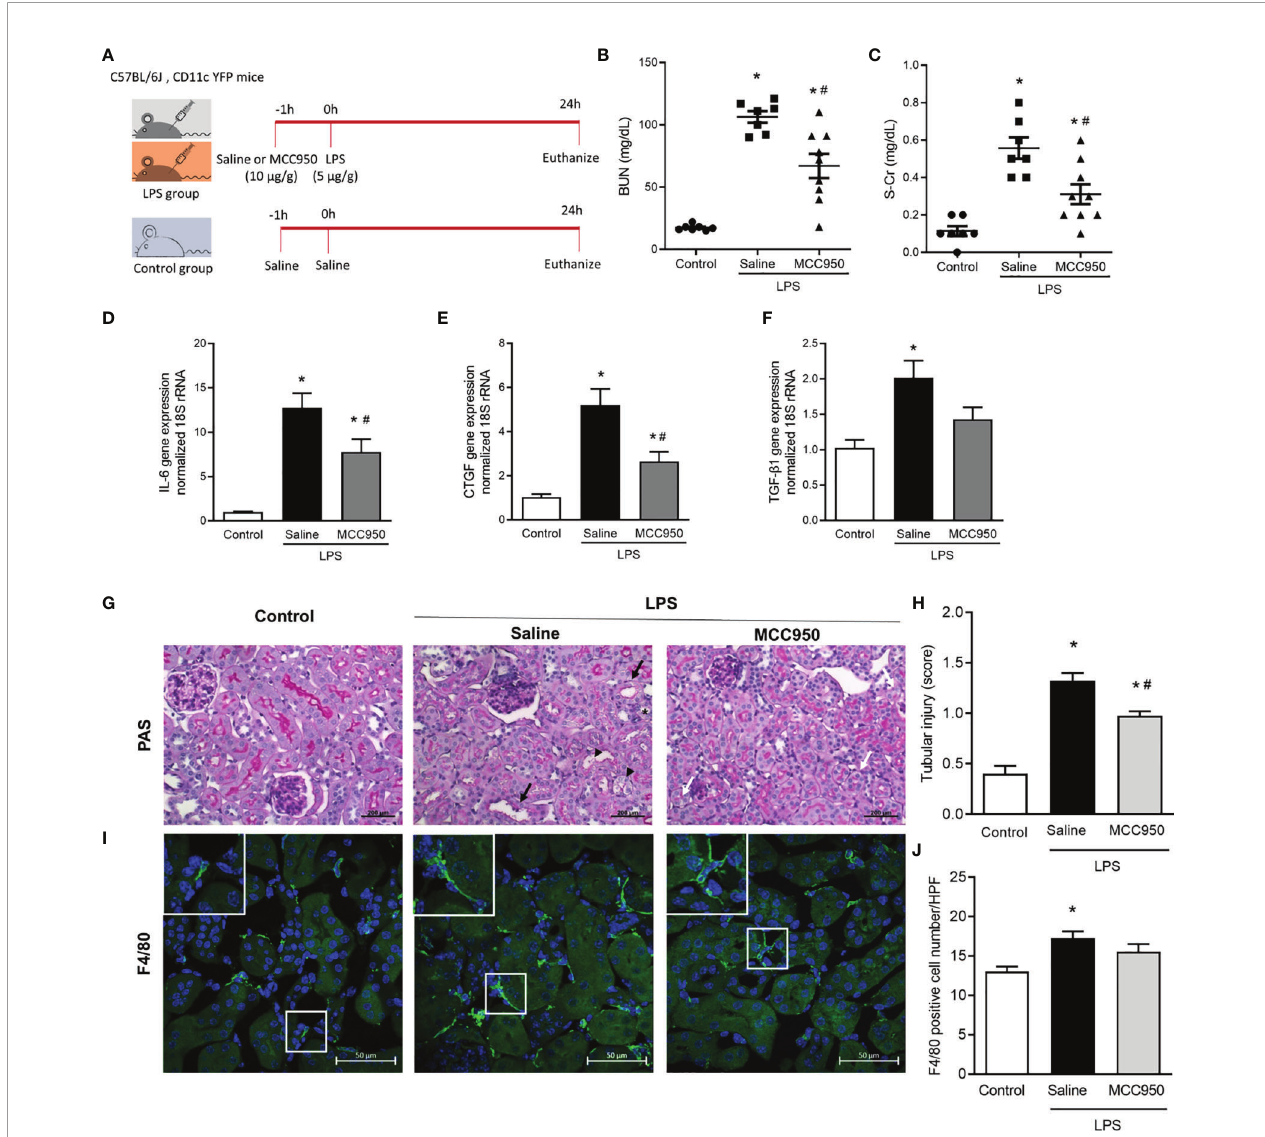
FIGURE 1 | NLRP3 inhibition attenuates LPS-induced AKI and in fl ammatory cytokine gene expression. (A) Experimental design of the study. (B) BUN. (C) Serum creatinine. Gene expression levels of (D) IL-6, (E) CTCF, and (F) TGF- b 1. (G) PAS staining shows tubular dilation (black arrows), tubular epithelial cell destruction (black arrow heads), loss of brush border (asterisk), and vacuolar deformation (white arrows). (H) Tubular injury score. (I) F4/80 staining. (J) F4/80+ cell counts. Data are represented as the mean ± SEM; n=7 for control and saline-treated LPS group, n=9 for MCC950-treated LPS group. BUN, blood urea nitrogen; IL-6, interleukin- 6; CTCF, connective tissue growth factor; TGF- b 1, transforming growth factor- b 1; PAS, periodic acid-Schiff; HPF, high power fi eld. * P <0.05 versus the normal control, # P <0.05 versus the saline-treated LPS